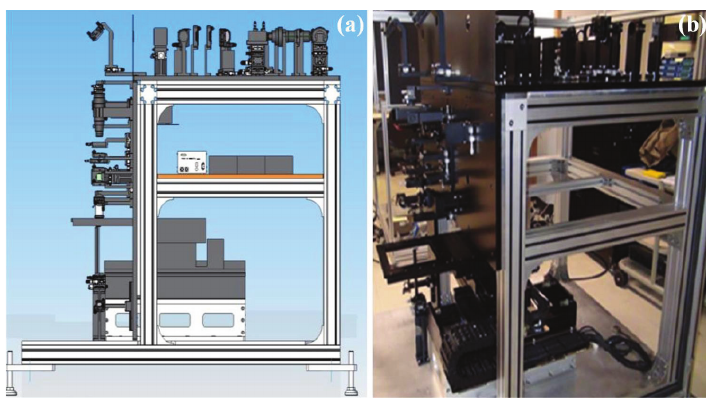
Figure 13. Schematic and prototype of the holographic stereogram printer produced by Lee’s group. (Reprinted with permission from ref [68],